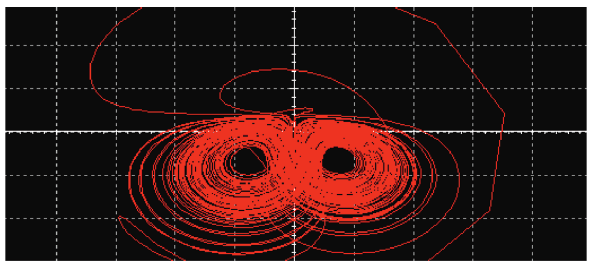
Figure 14: ( x,z ) space portrait of the Multisim simulation of equations (49)–(51).